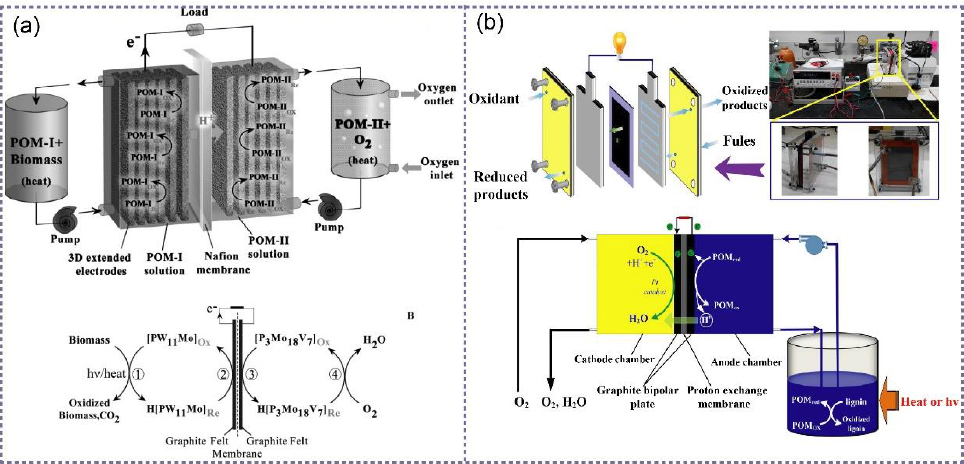
Figure 7. ( a ) Structure and working process of the LCFC. ( b ) Structure of the POM-mediated direct biomass fuel cell (From Refs. [100,101]).